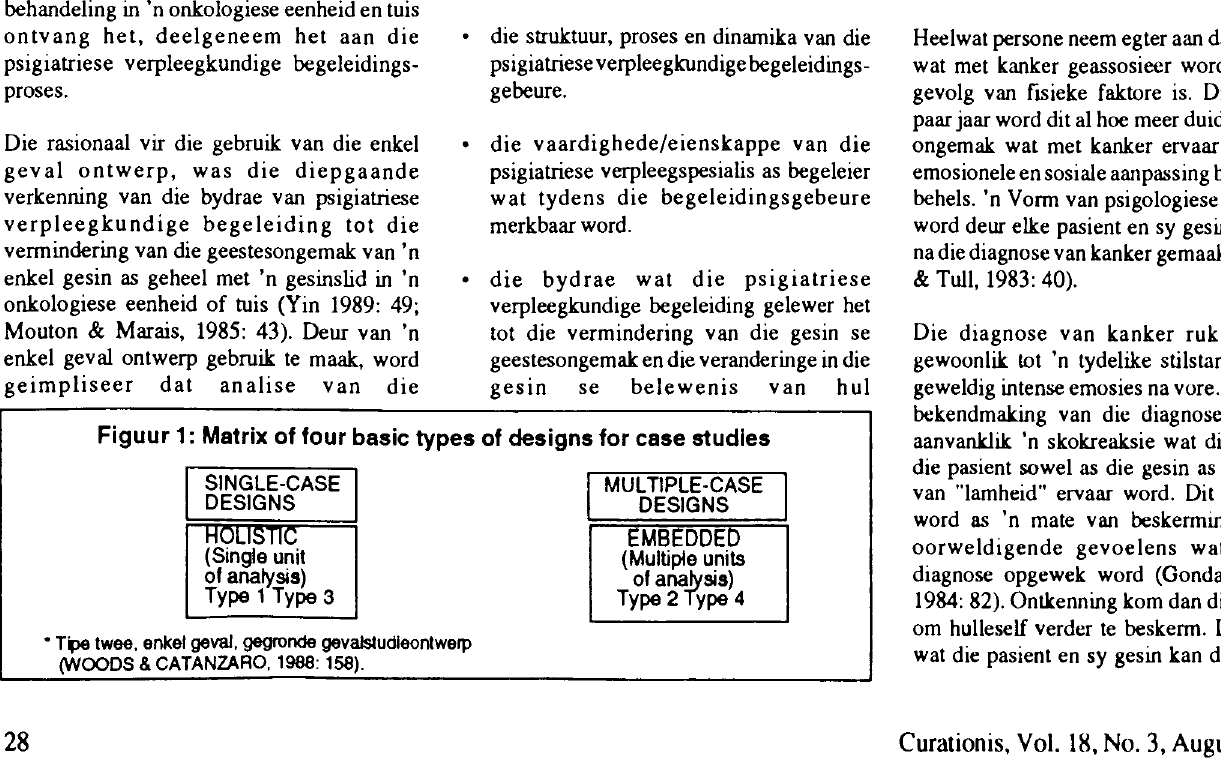
Figuur 1: Matrix of four basic types of designs for case studies SINGLE-CASE DESIGNS TT0LI5TIC (Single unit of analysis) Type 1